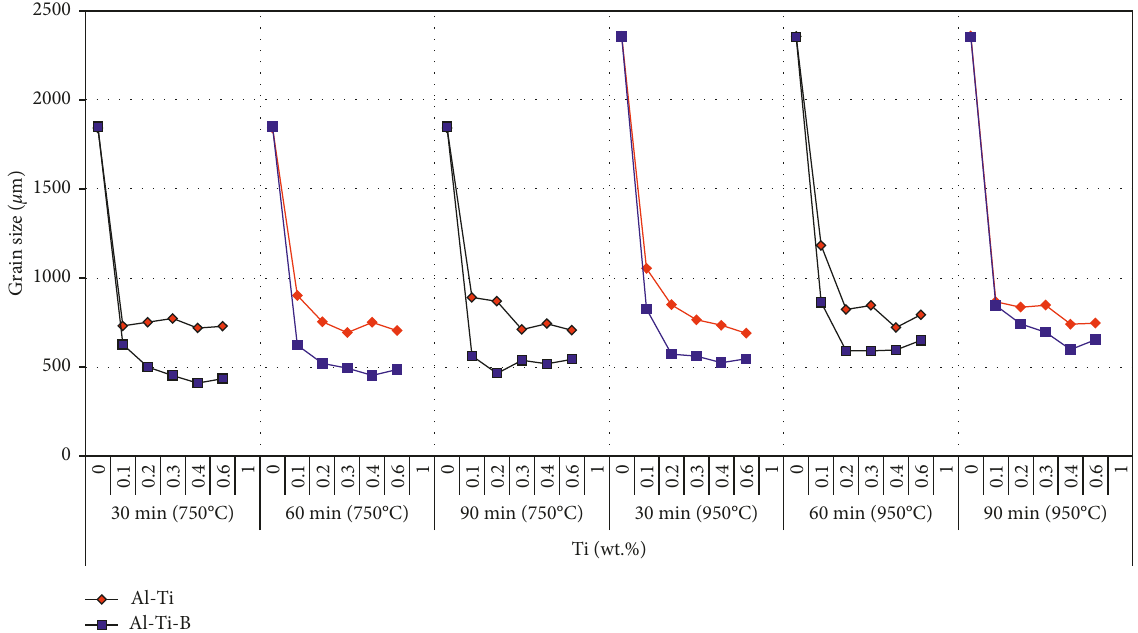
Figure 4: Variation in the grain size as a function of added Ti and melting conditions.